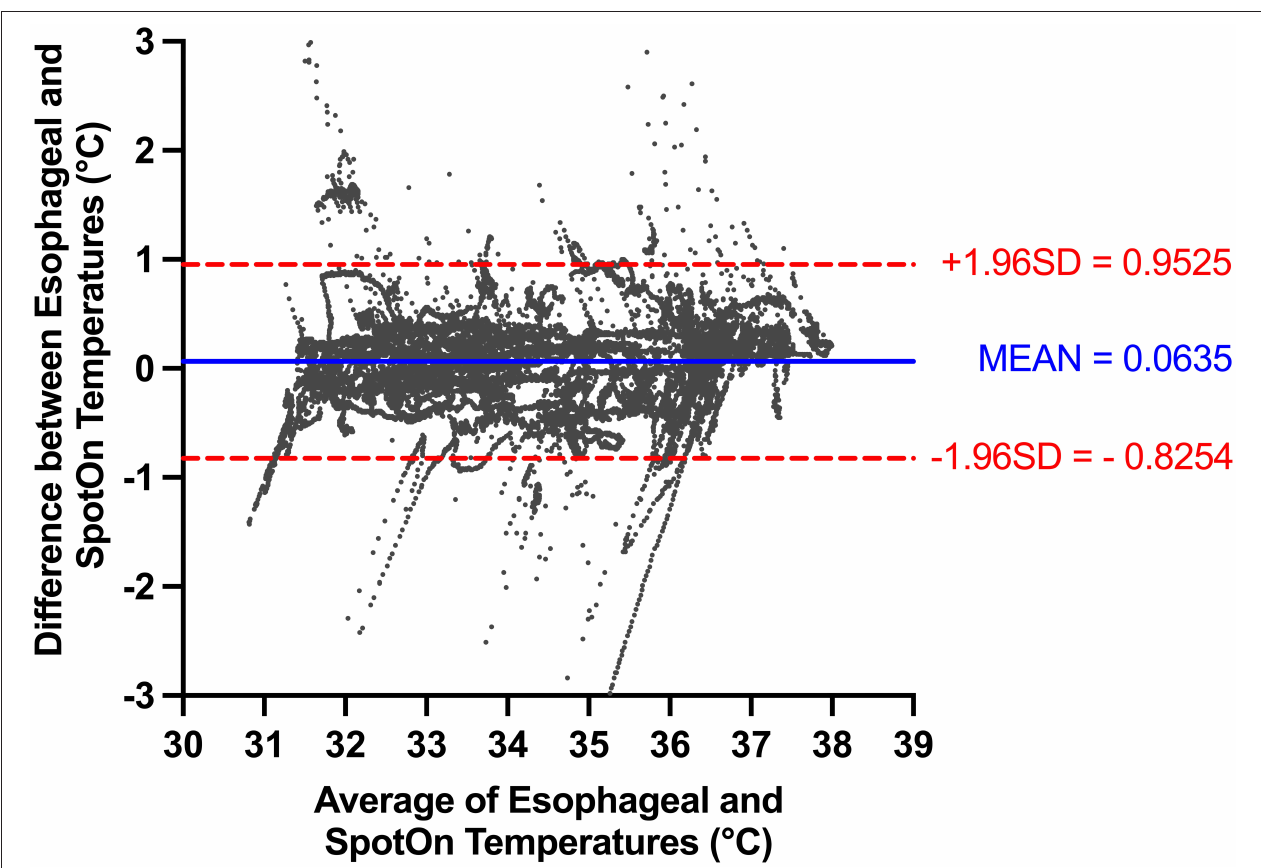
FIGURE 3 | Bland-Altman analysis comparing SpotOn TM and the esophageal temperature